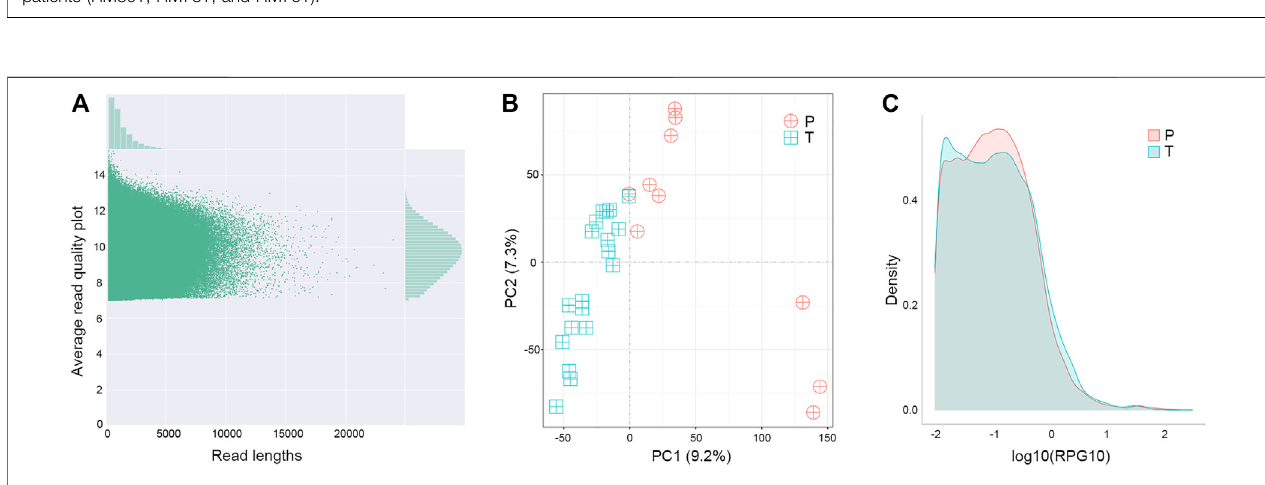
Frontiers in Cell and Developmental Biology |